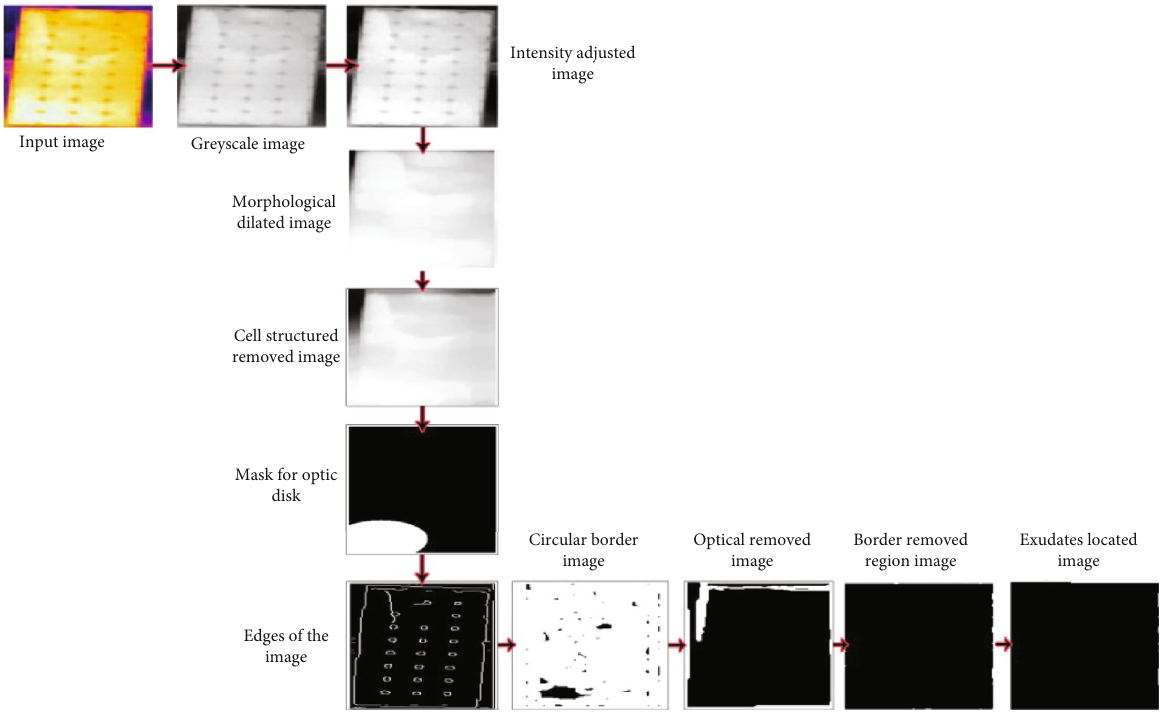
Figure 8: Aged solar panel thermal image processed.